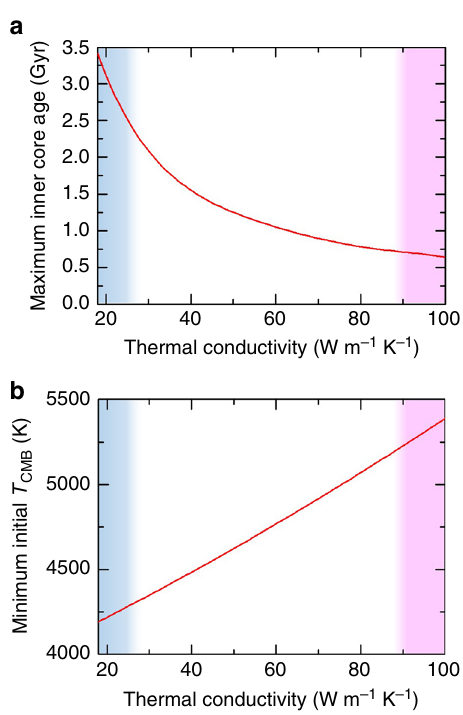
Fig. 3 Effects of core thermal conductivity on its thermal evolution. a maximum inner core age and b minimum initial core – mantle boundary (CMB) temperature as a function of thermal conductivity of the core. Results are obtained with a thermal evolution model assuming an isentropic CMB heat fl ow at each time, which is the minimum to maintain a magnetic fi eld by thermal convection alone. Blue shaded areas represent the range of Fe 0.85 Si 0.15 thermal conductivity at outer core P – T conditions indicated by our study, while red shaded areas represent the high thermal conductivity values of Fe – Si alloys inferred from literature results, see e.g., refs. 25,27